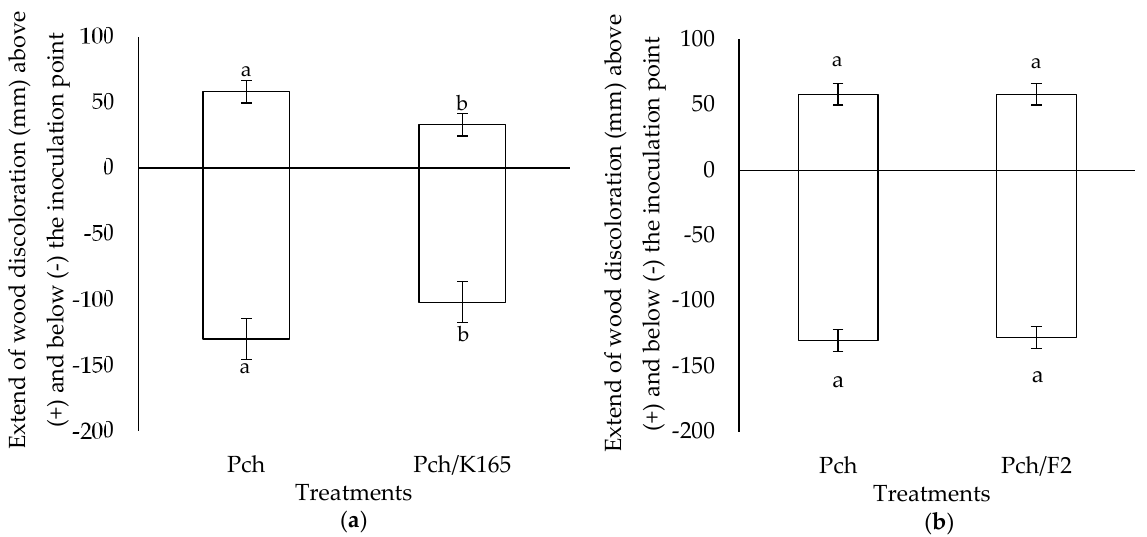
Figure 3. Extent of the wood discoloration above and below the Phaeomoniella chlamydospora inoculation point in the Paenibacillus alvei K165 (Pch/K165) ( a ), Fusarium oxysporum F2 (Pch/F2) ( b ), and control (Pch) treated grapevines. The columns represent the means of three biological repeats ( n = 3) (with eight grapevines per treatment and repeat). At each site (above or below the inoculation point), columns with different letters are significantly different from each other, according to a t-test ( p < 0.05). The vertical bars indicate the standard difference value.